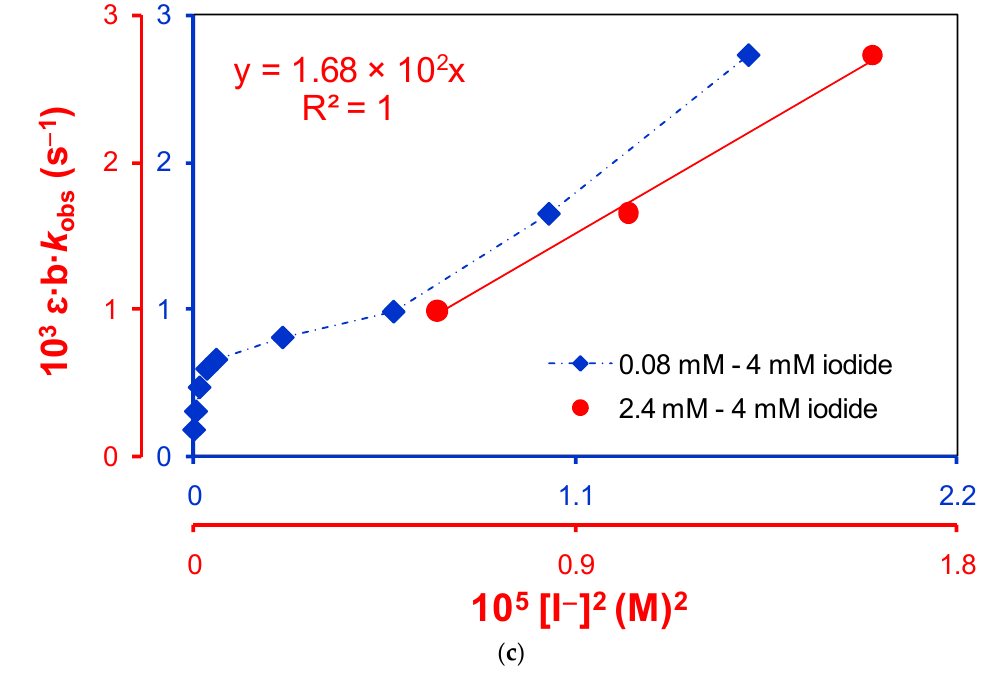
Figure 3. ( a ) Plot of the first order with respect to iodide. ( b ) Fractional (0.5) order plot with respect to iodide. ( c ) Second-order plot with respect to iodide.